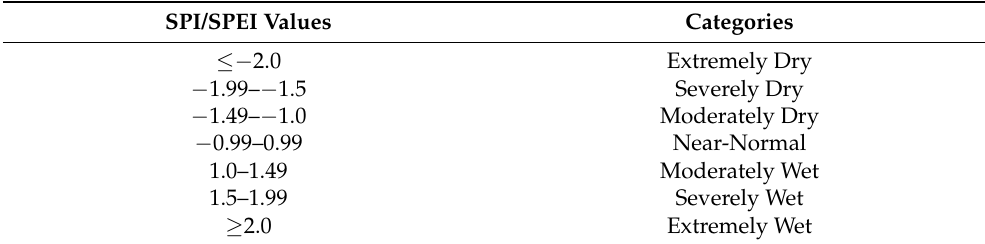
Table 2. Classification of the severity of drought (or wet) events based on the calculation of SPI/SPEI